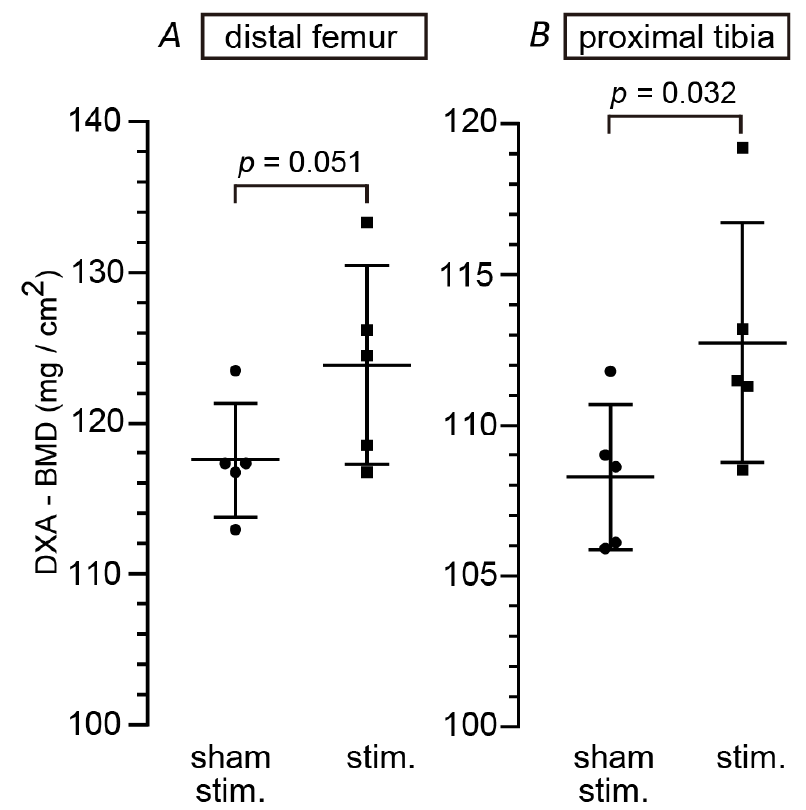
Figure 4. SLN stimulation increased BMD in OVX rats. After 3–4 weeks of SLN stimulation (0.5 ms, 90 µ A, 40 Hz for 8 min / hour × 7 times / day × 4 days / week), femur and tibia were removed and BMD was measured by the DXA method. BMDs in distal metaphysis of femur ( A ) and proximal metaphysis of tibia ( B ) were compared between SLN-stimulated rats ( n = 5) and nonstimulated (sham) rats ( n = 5). Group data are expressed as mean ± SD. Closed circles and squares indicate data obtained from individual rats. The p values were obtained by unpaired t -test